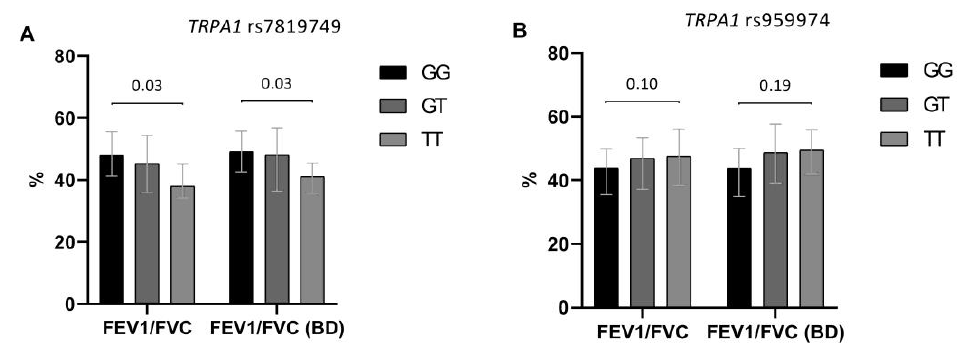
Figure 2. Effect of TRPA1 rs7819749 ( A ) and TRPA1 rs959974 ( B ) polymorphisms on baseline and post-bronchodilator (BD) FEV1/FVC in the studied COPD patients ( n = 143). The results are presented as median, lower and upper quartiles. Denoted levels of significance are FDR corrected and correspond to the differences in FEV1/FVC between homozygous genotypes.